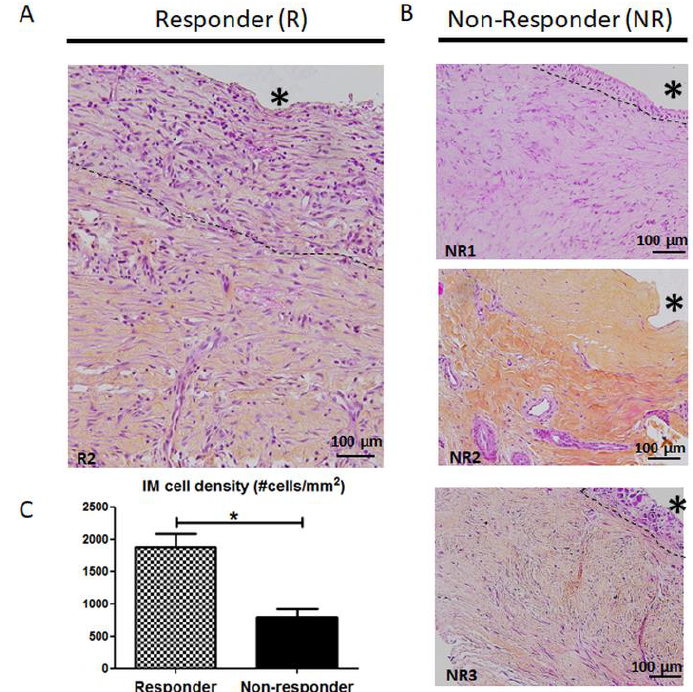
Figure 1. Representative hematoxylin and eosin-stained IM for ( A ) responder patient (patient R2) and ( B ) non-responder patients (NR1, NR2 and NR3). Responder patients present well organized IM characterized by a rich cellular network in contact with polymethyl-methacrylate (PMMA, * indicates the PMMA site before its removal) and a thick vascularized layer in contact with muscles. In comparison, non-responder patients display poorly structured and poorly cellularized IM (scale bar = 100 μm). ( C ) Cell density in IM from responder and non-responder patients. Results are shown as the mean +/- SEM, * p < 0,05.